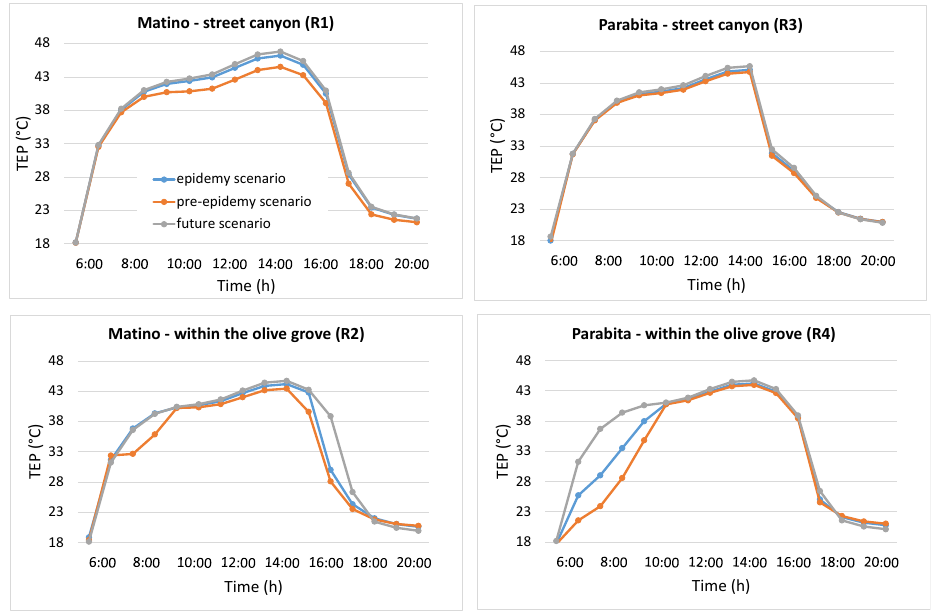
Figure 7. Temperature of equivalent perception (TEP) hourly profiles for Matino (left) and Parabita (right) inside the street canyon (top) and within the olive grove (bottom) (see Figure 3 for the position of R1, R2, R3 and R4 receptors).